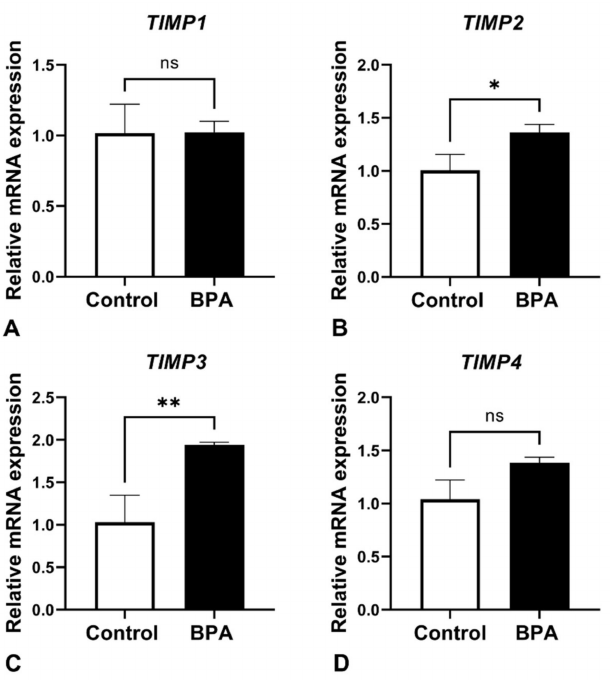
Figure 7. TIMP 1 ( A ), TIMP 2 ( B ), TIMP3 ( C ) and TIMP 4 ( D ) gene expression in the control and BPA-treated groups. Note: no significant differences (ns), * p < 0.05 and ** p < 0.01.